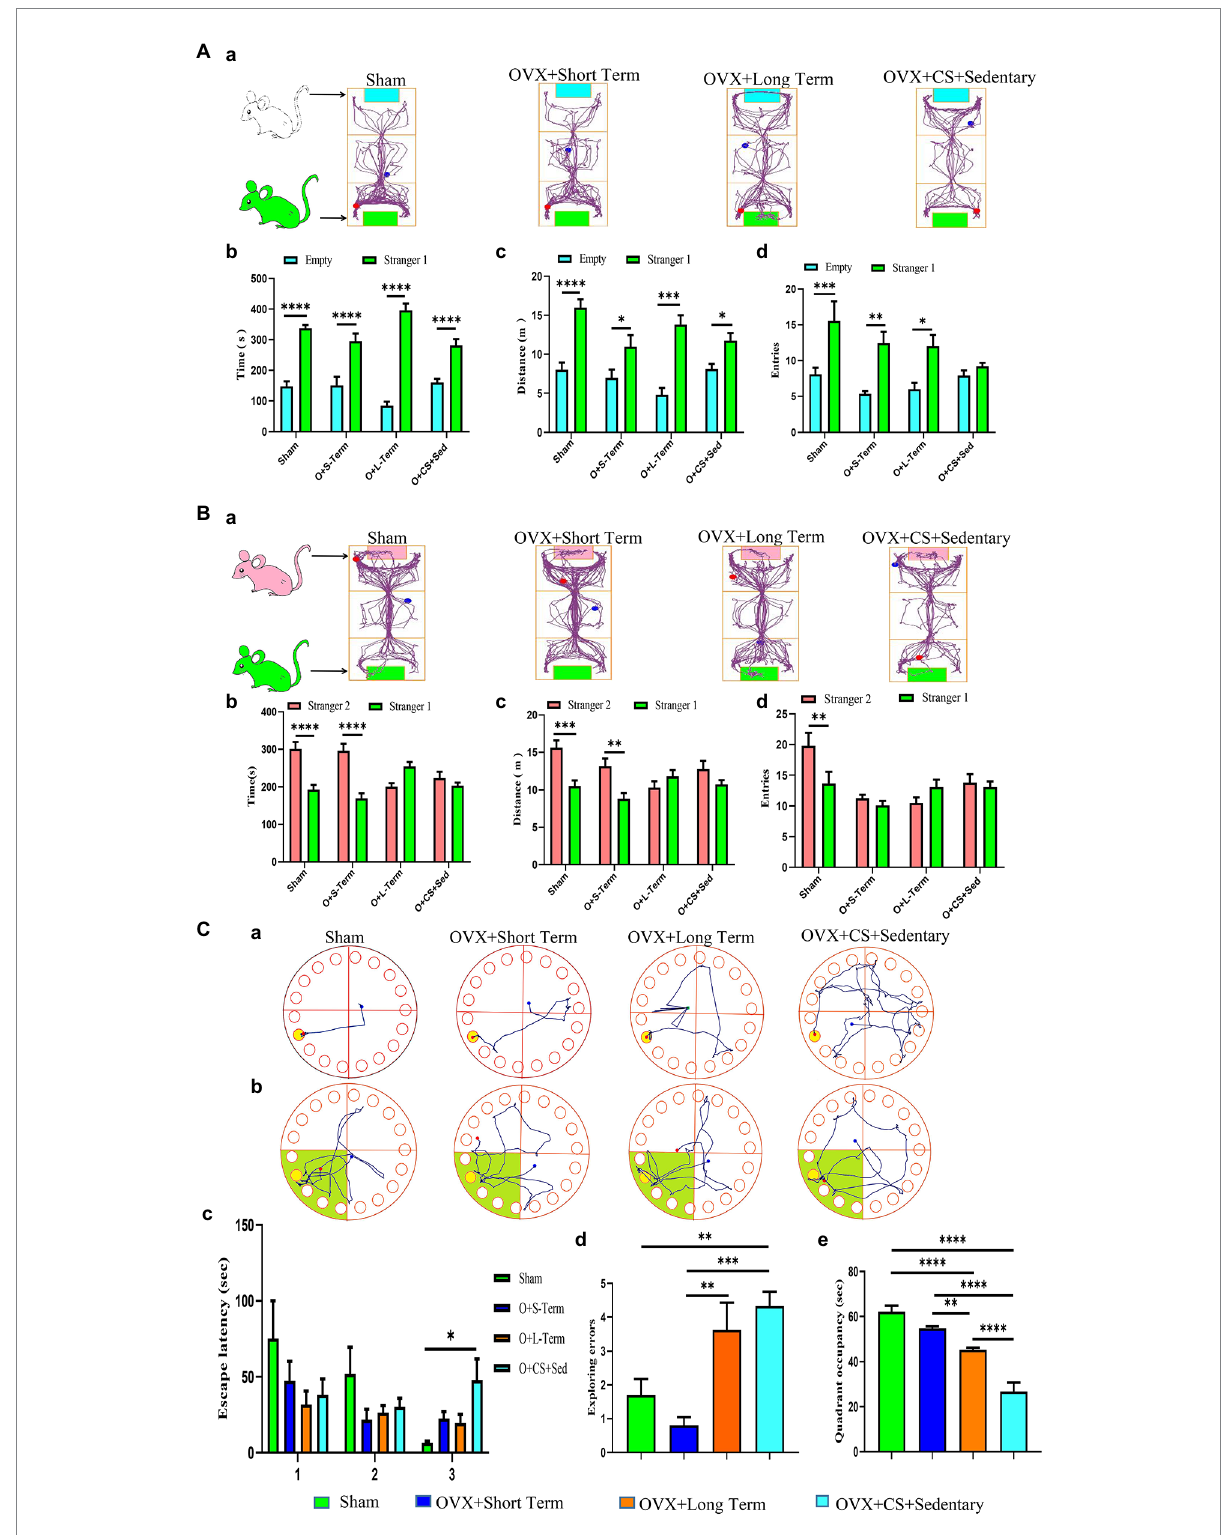
FIGURE 2 Ovariectomy accelerates the development of chronic stress-induced deficits in social functioning and spatial learning memory. (A) Representative locomotor trajectory plots of each group of rats in the three-chamber socialization test session I (a) . Duration of activity (b) , distance of activity (c) , and number of entries (e) of test rats in empty area or stranger 1 area. (B) Representative activity trajectories of each group of rats in the three-chamber social test Session II (a) . Activity time (b) , activity distance (c) , and number of entries (e) of the test rats in the stranger 2 area or the stranger 1 area. (C) Representative movement trajectories of each group of rats during the training period (a) and exploration period (b) in the Barnes maze task. Analyses were performed to record latency time during the training period (c) , the number of errors in exploring the escape box during the exploration period (d) , and dwell time in the target quadrant (e) . All values are expressed as mean ± SEM. ( n = 8–12), * P < 0.05, ** P < 0.01, *** P < 0.001, **** P <